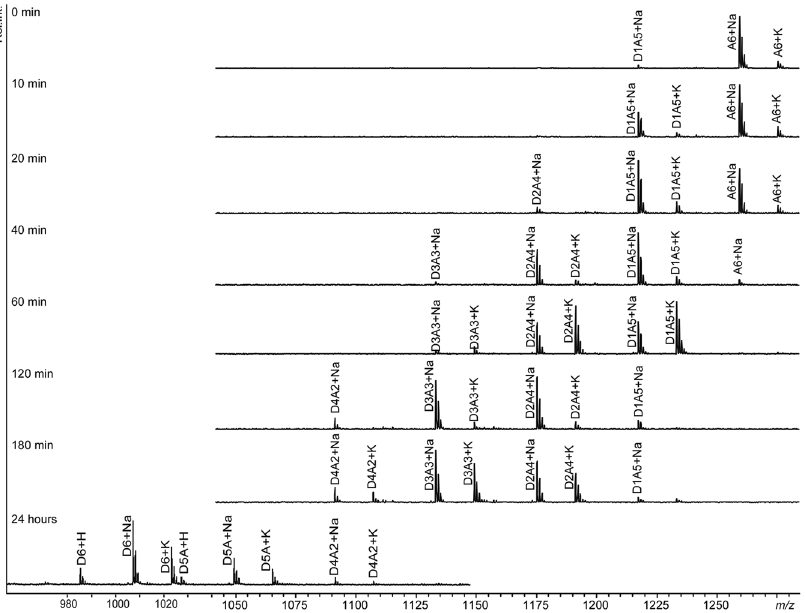
Figure 4. Product profiles during deacetylation of (GlcNAc) 6 by An CDA. The reaction mixture contained 2 mM (GlcNAc) the reaction. The 24 hours sample is from a similar reaction, with higher (1 µ M) enzyme